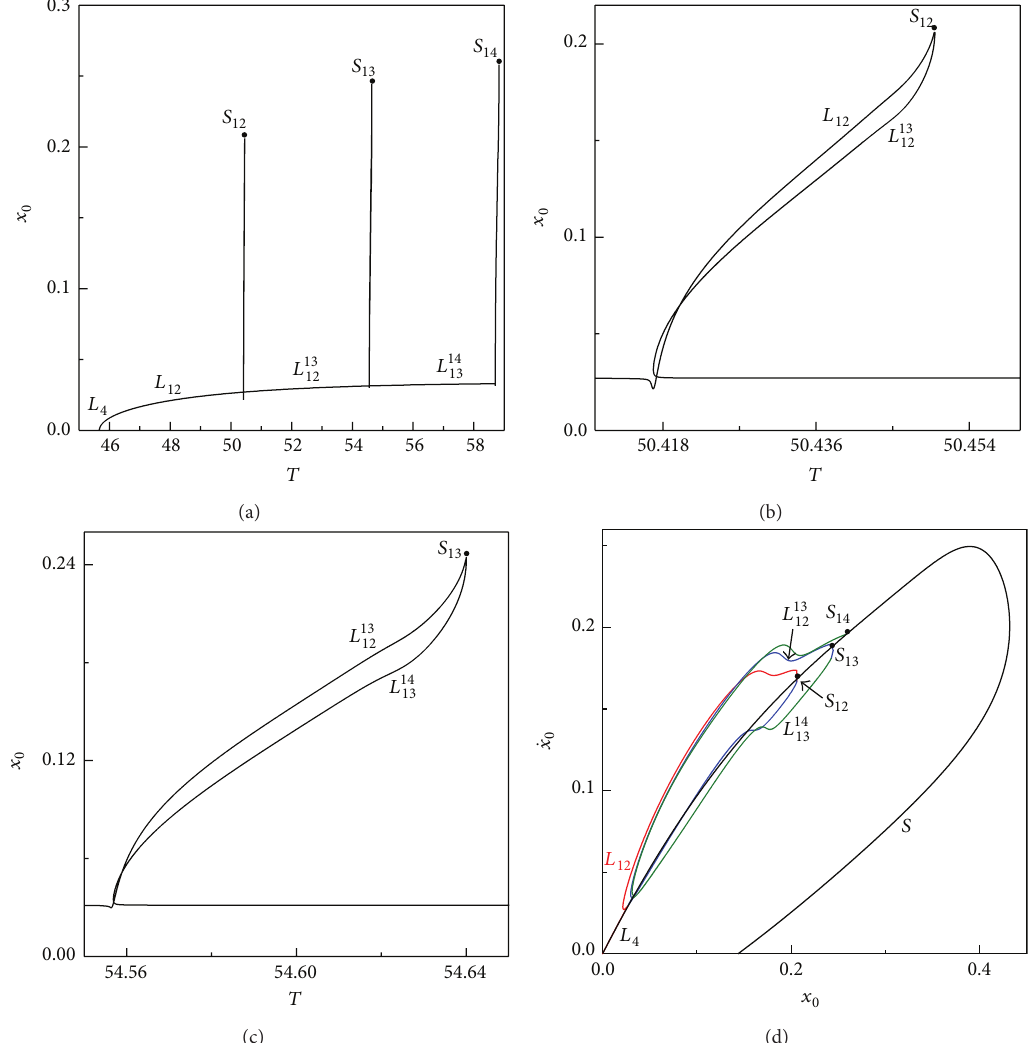
Figure 11: Projection of the characteristic curve of the long period family for the parameter values 𝑞 1 = 0 . 5, 𝑞 2 = 0 . 8, 𝜔 = 1 . 5, and 𝜇 = 0 . 00095 (a) in the (𝑇, 𝑥 0 ) plane; (b), (c) magnifications of certain parts of the first frame showing the evolution in detail and (d) in the (𝑥 0 , ̇𝑥 0 ) plane.